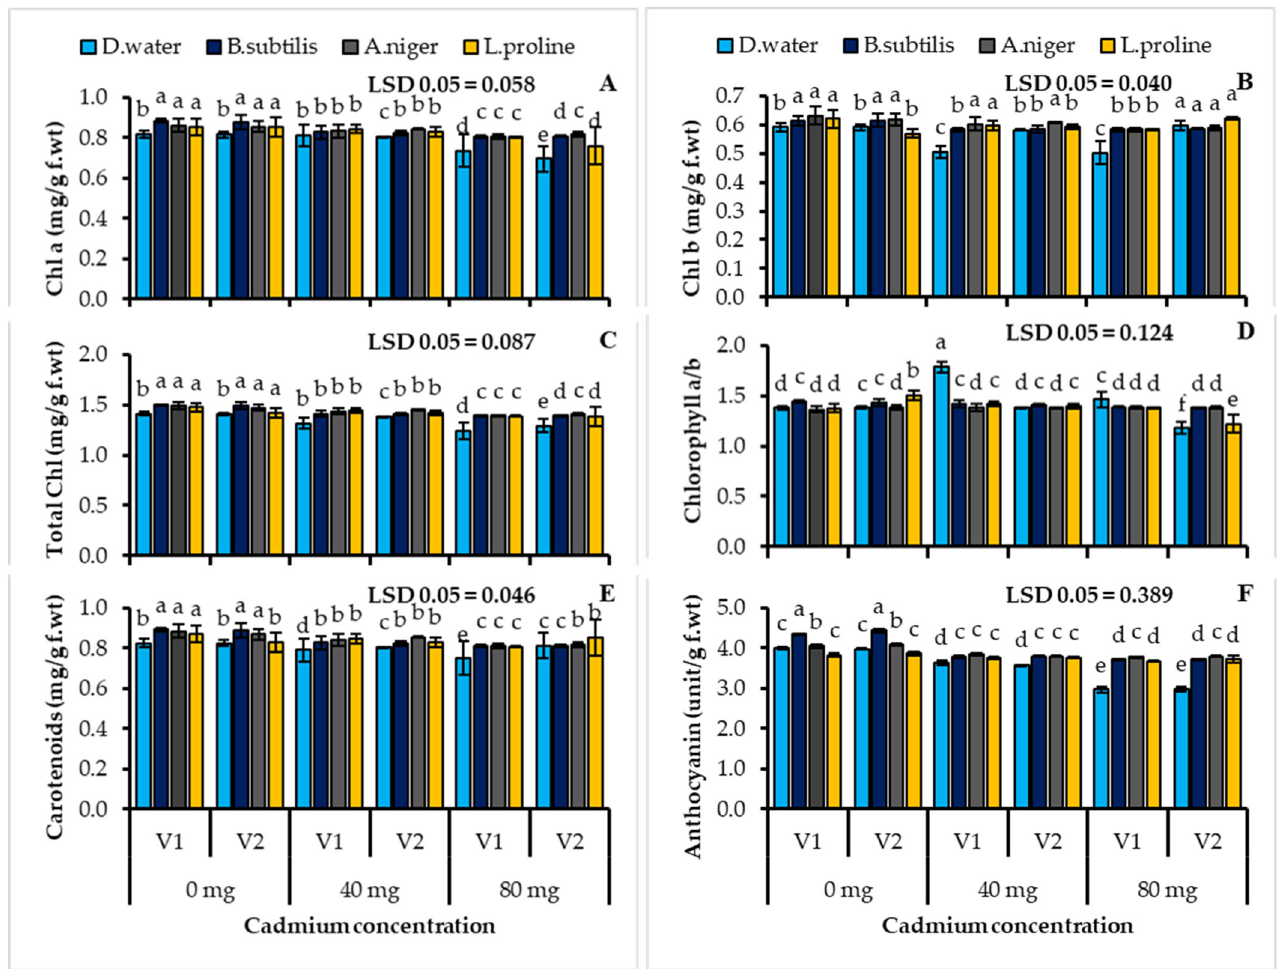
Figure 2. Chlorophyll a ( A ) chlorophyll b ( B ) total chlorophyll ( C ) chlorophyll a/b ( D ) carotenoids ( E ) and anthocyanin ( F ) contents of two cultivars of wheat ( Triticum aestivum L.) treated with Bacillus subtilis , Aspergillus niger and L-proline subjected to the cadmium stress conditions (Mean ± S.E.). Here V1 = AKBAR and V2 = DILKASH. The lower-case letters represent the significant difference in data.